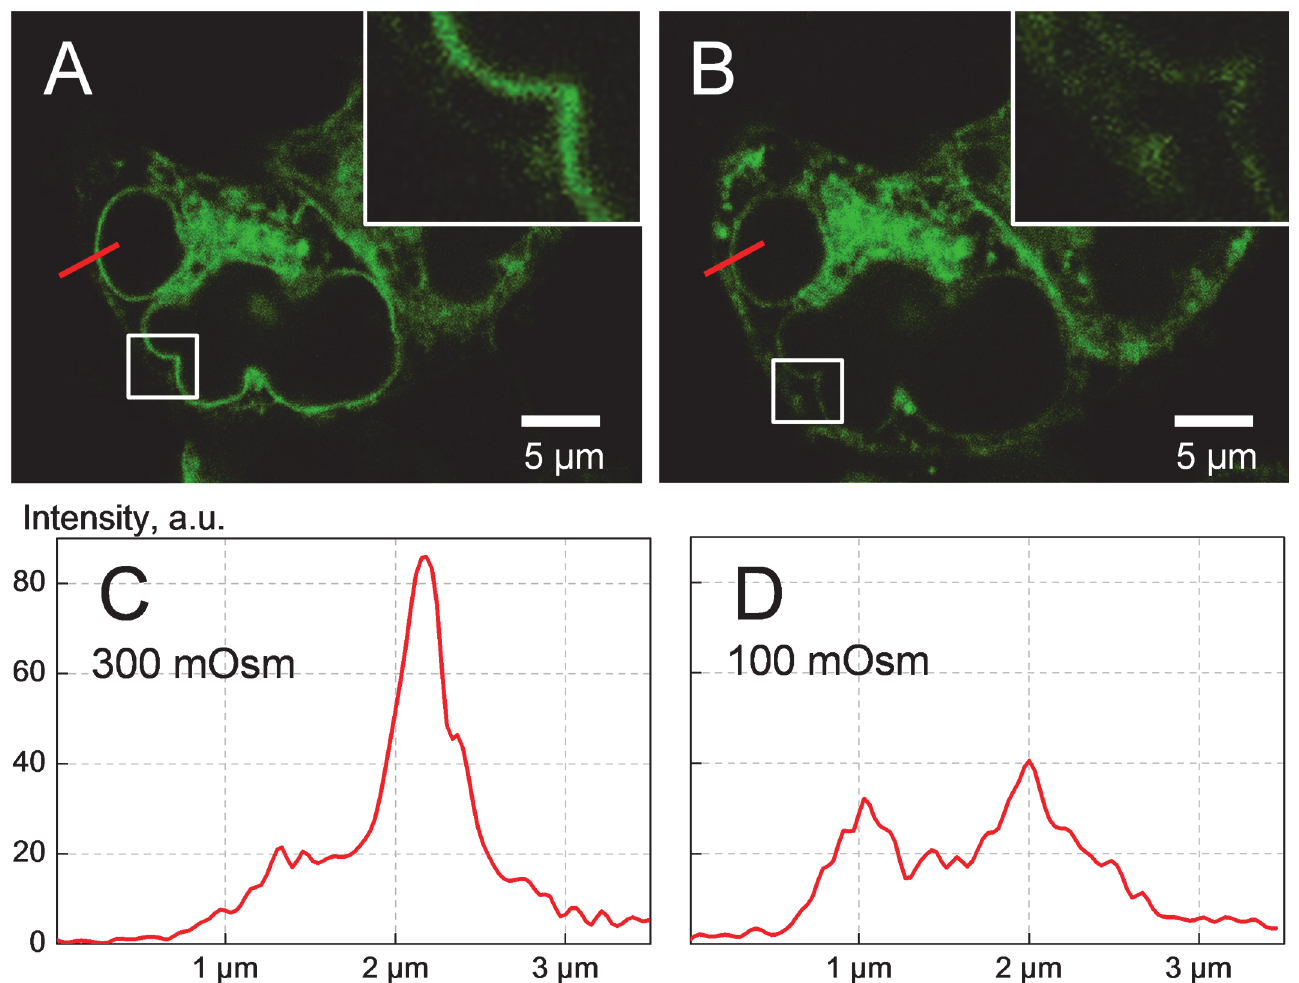
Fig 4. Confocal fluorescence imaging of HEK293 cells overexpressing the fusion protein SLC5A3-EGFP. The images A and B were taken, respectively, under isotonic conditions and 10 min after application of a strongly hypotonic 100-mOsm myo-inositol-substituted solution. Hypotonic cell swelling is clearly seen in ( B ). The insets and the intensity diagrams ( C and D ) illustrate the impact of hypotonic stress on the intracellular distribution of the fusion protein. Comparison of the diagrams C and D reveals a marked hypotonicity-mediated depletion of the protein in the perinuclear regions along with its increase in the peripheral cytoplasm. Together, these findings suggest that hypotonic swelling caused translocation of a large portion of SLC5A3-EGFP towards the plasma